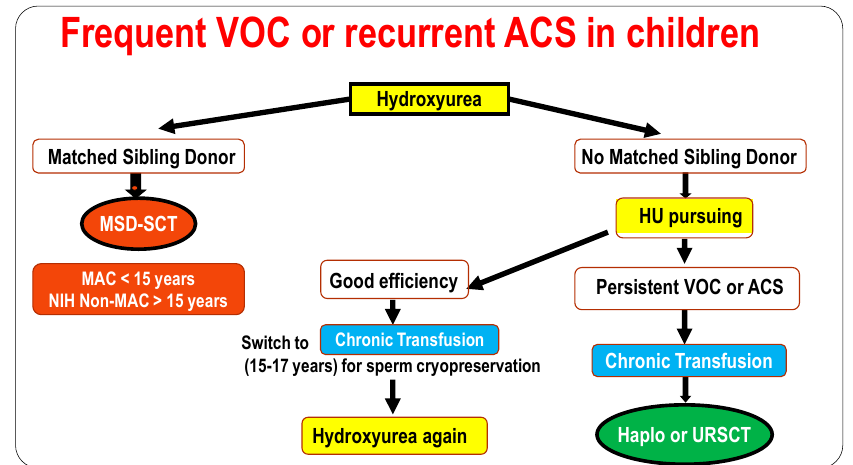
Figure 4. Indications of the different treatments: hydroxyurea, chronic transfusion and. which kind of stem cell transplantation to propose in children with frequent vaso-occlusives or recurrent acute chest syndrome Abbreviations: VOC = vaso-occlusive crisis, ACS = acute-chest syndrome, HU = hydroxyurea, MSD = matched-sibling donor, SCT = stem cell transplantation, Haplo = related